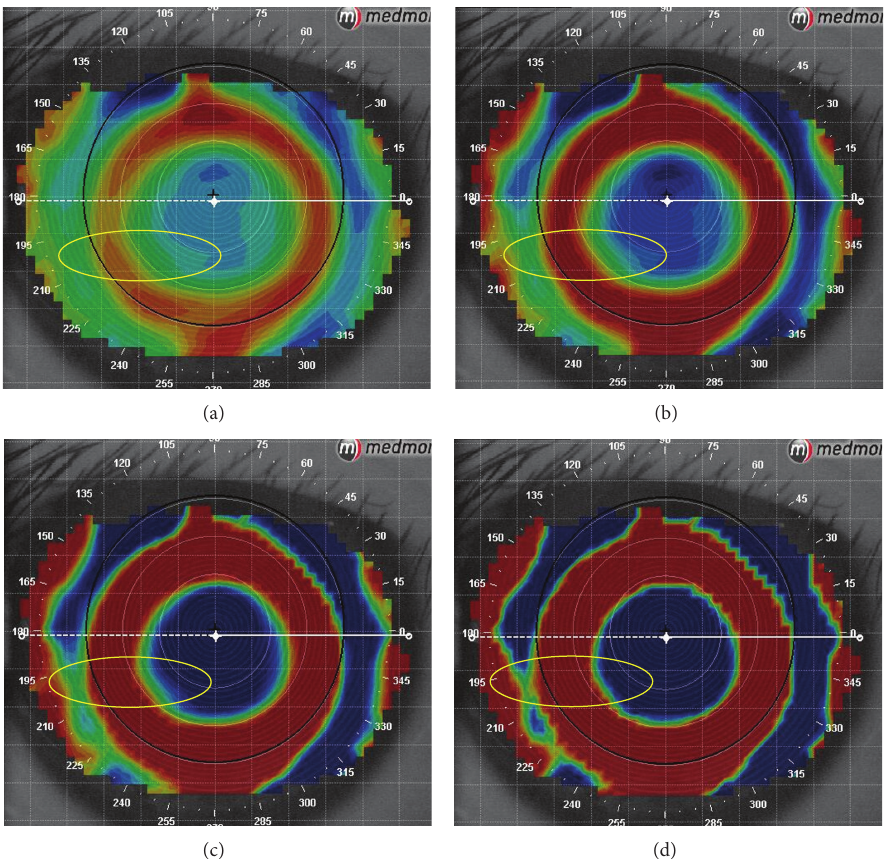
Figure 2: Difference of the same topography read in different “step sizes.” (a) Step size is 1.00D. (b) Step size is 0.50 D. (c) Step size is 0.25 D. (d) Step size is